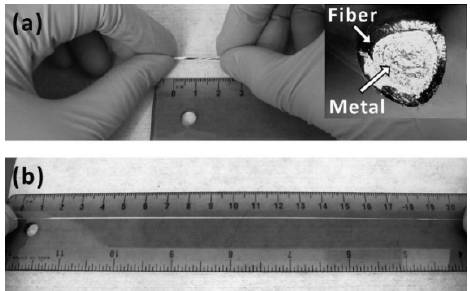
Figure 1. ( a ) A relaxed, 2 cm section of a stretchable conductive fibre. The shiny core of its cross-section (inset) is the liquid metal. ( b ) The fiber is stretched to 20 cm and the metal appears to uniformly fill the stretched fiber [14].